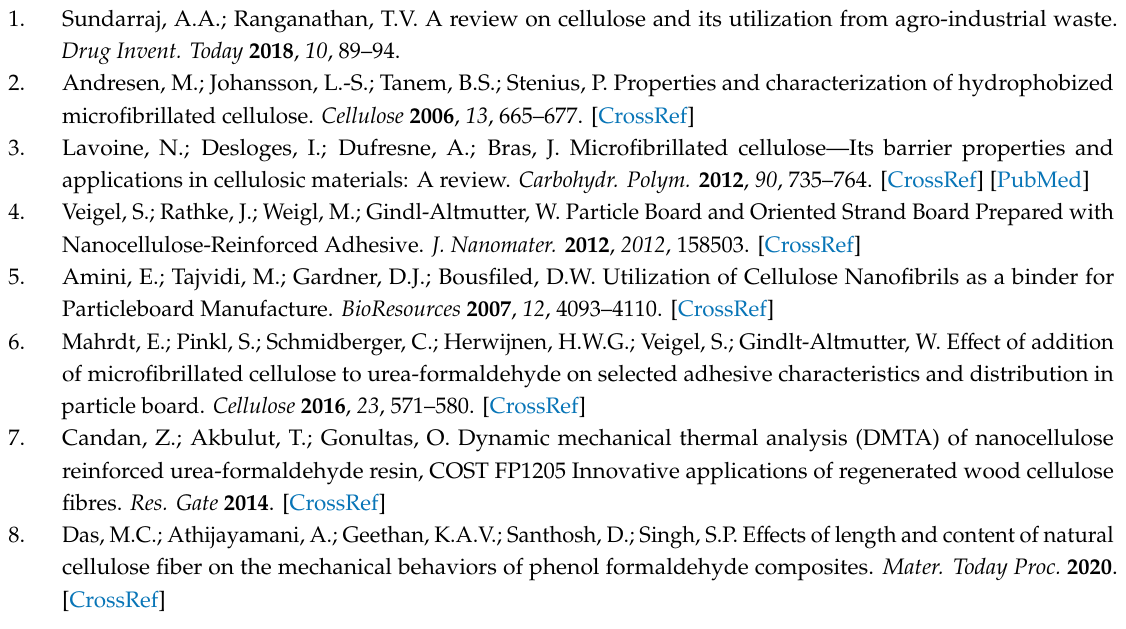
Sample Availability: Samples of the MFC are available from Borregaard. Samples of resins are available from the